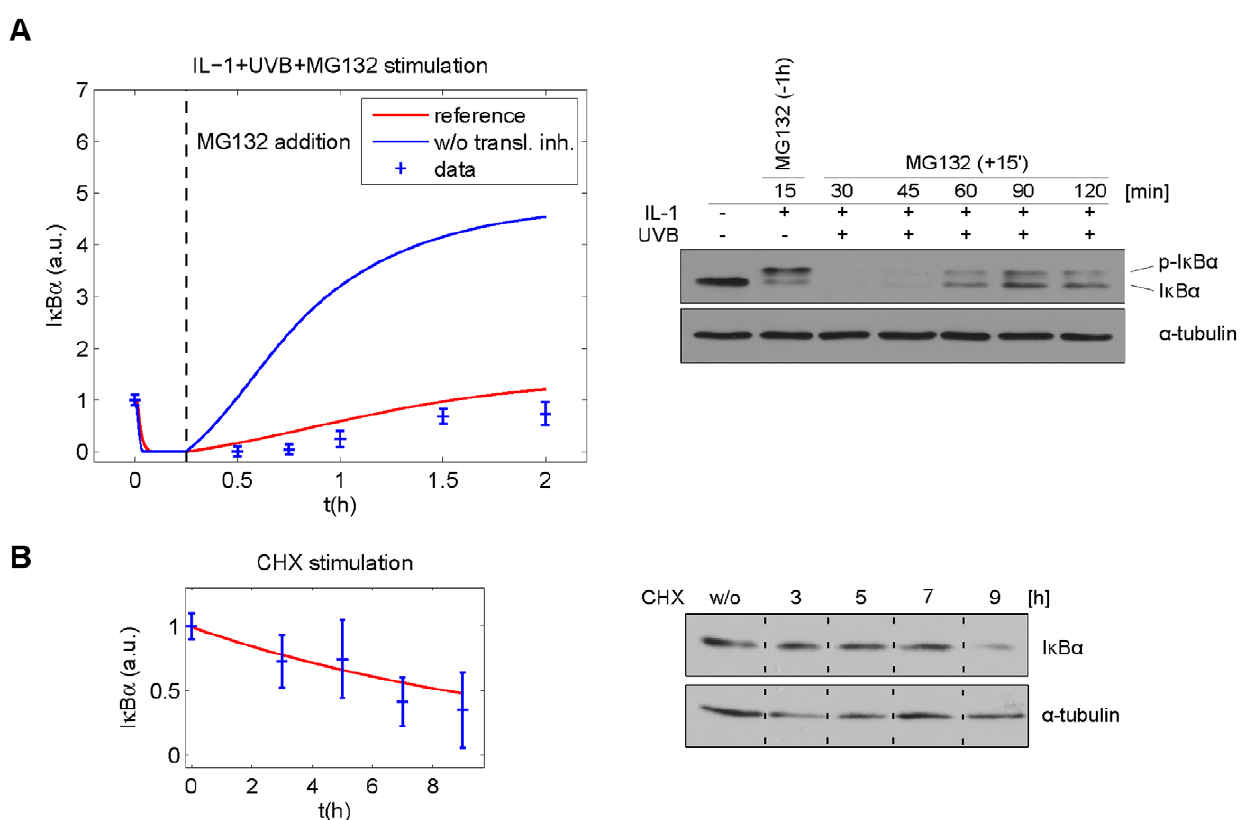
Figure 3. Model prediction and validation. ( A ) The models M Ref and M T predict markedly different I k B a concentrations following IL-1 and UVB stimulation and addition of proteasome inhibitor MG132 15 min post stimulation. The proposed experiment follows the concentration course predicted by the reference model. This confirms the hypothesis that both PP2Ac deactivation and translational inhibition are relevant processes for the lack of I k B a recurrence. KB cells were left untreated or stimulated with IL-1 + UVB for the indicated time points. The proteasome inhibitor MG132 (MG) was applied 1 h in advance ( 2 1 h) or 15 min after initial IL-1 stimulation ( + 15 9 ). The status of I k B a protein was determined by Western blot analysis. Equal loading was monitored by reprobing the membrane with an anti a -tubulin antibody. The quantified blots were standardised to an initial value of 1. Parameter values were optimised using the data for IL-1, IL-1 + UVB and UVB, but not for IL-1 + UVB + MG132 stimulation. ( B ) Experimental predictions are perfectly in line with I k B a concentrations following CHX stimulation. KB cells were left untreated or stimulated with the translation inhibitor cycloheximide (CHX) for the indicated time points. The status of I k B a protein was determined by Western blot analysis. Equal loading was monitored by reprobing the membrane with an anti a -tubulin antibody. Protein bands shown are extracted from the same membrane under identical conditions. Parameter values were optimised using the data for IL-1, IL-1 + UVB, UVB and IL-1 + UVB + MG132 stimulation, but not for CHX